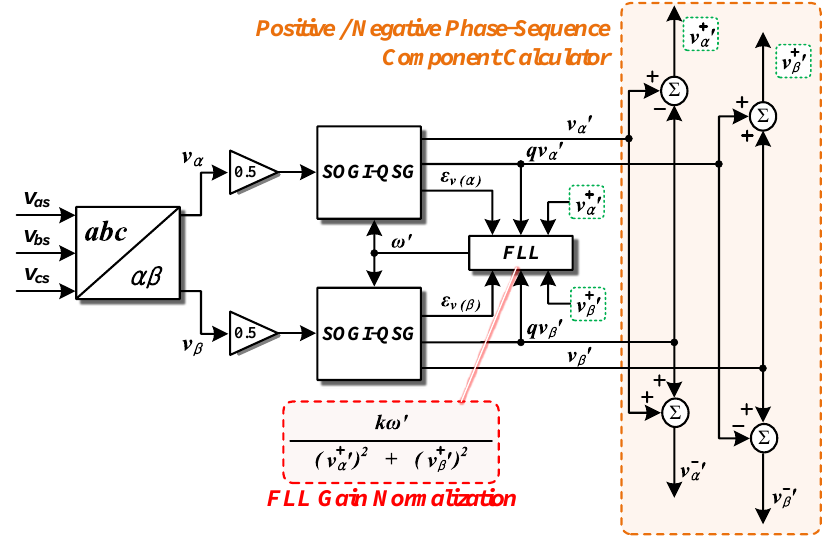
Figure 13. Positive sequence voltage extractor using 3-phase SOGI-FLL.